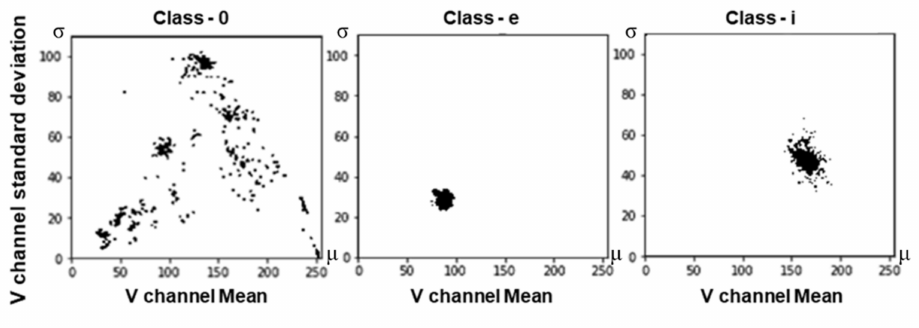
Figure 7. V channel distribution: showing the mean number of pixels and standard deviation for classes 0, e, and i.